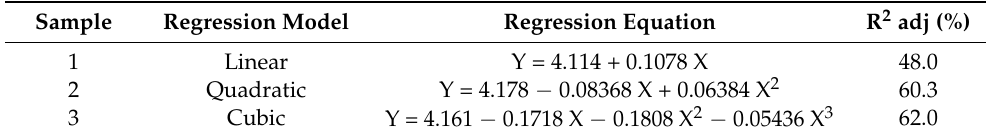
Table 4. The orthogonal polynomial regression model for the flexural strength of the mortar with OPS-activated charcoal.